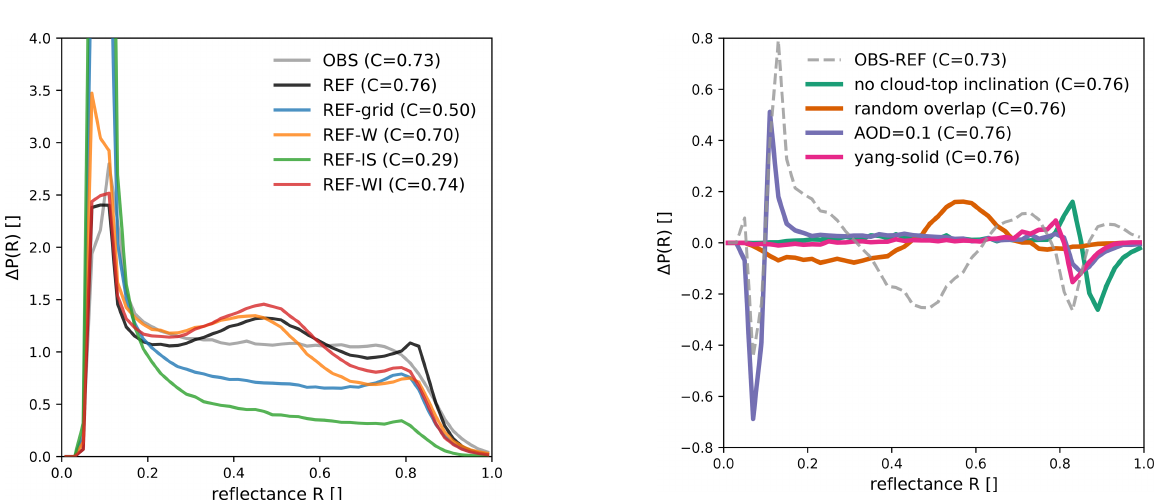
Figure 9. The 0.6µm SEVIRI solar reflectance histograms for the test period computed for the observations (OBS) and the refer- ence experiment (REF). The additional distributions were com- puted using only the grid-scale clouds (REF-grid), only the water clouds (REF-W) and only the ice clouds (REF-IS) of the reference experiment respectively. For the red line (REF-WI), water and ice clouds are taken into account, and only the snow contribution to the ice clouds is omitted. The numbers in the legend indicate the cloudiness, i.e. the fraction of pixels exceeding a reflectance of 0.2.